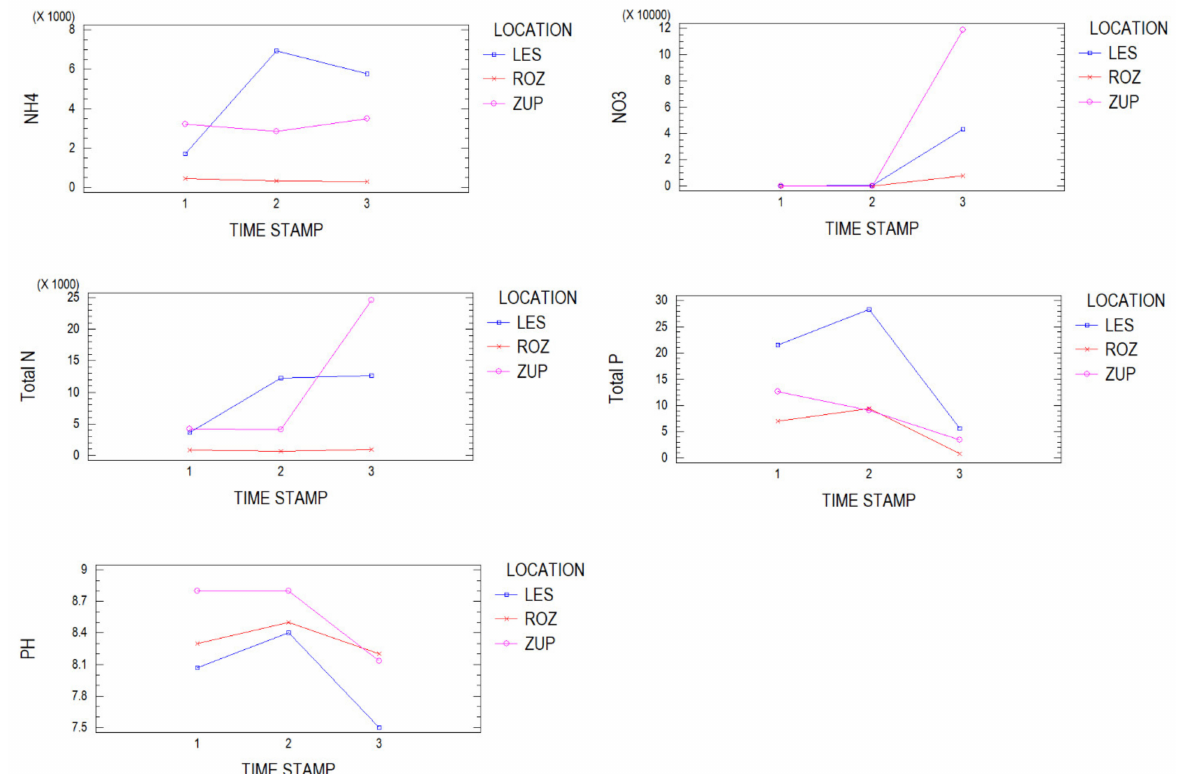
Figure 5. Leachate: Two-factor interactions; composting protocol (LES, ROZ, ZUP) and Time stamp (1, 2,